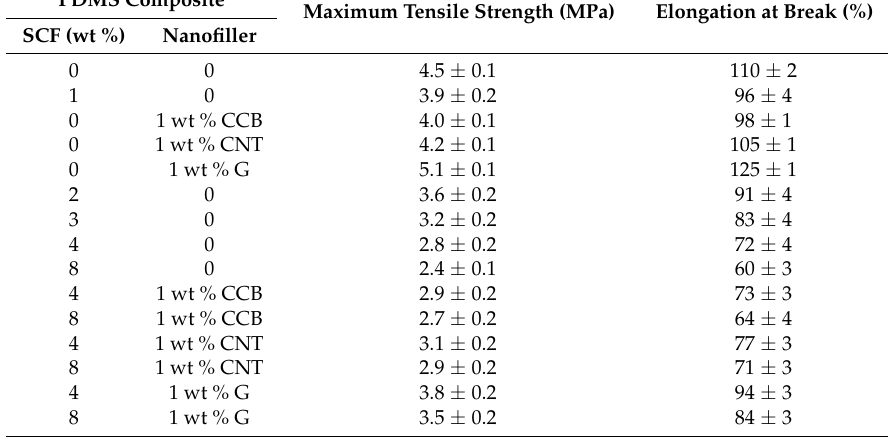
Table 2. Mechanical properties of PDMS composites at thickness 0.2 mm.